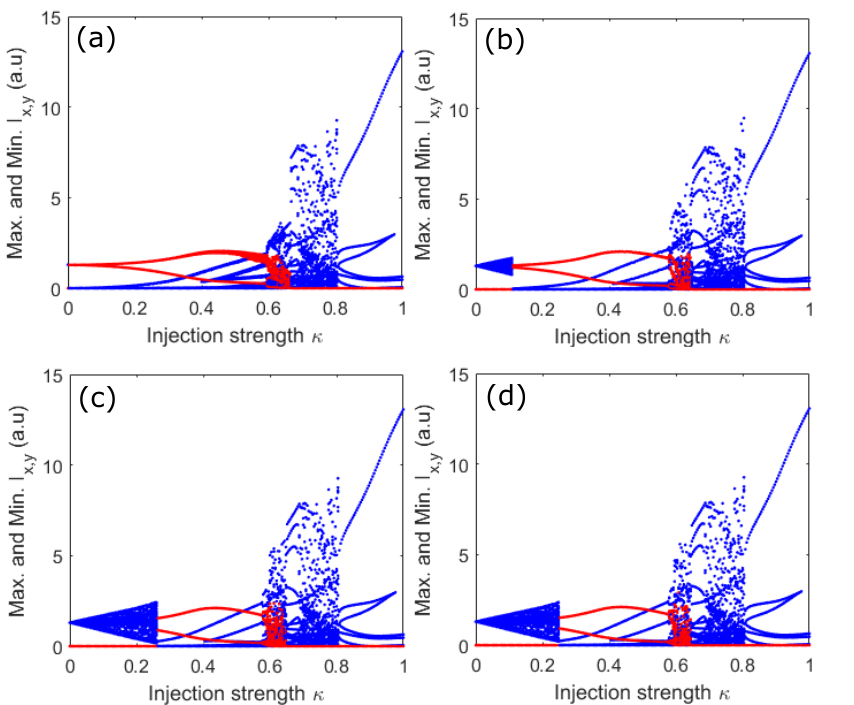
Figure 12. Bifurcation diagrams for fixed injected comb spacing Ω = 2 GHz and detuning ∆ ν x = − 9 GHz when varying γ s . ( a – d ) are obtained for γ s = 50 ns and γ s = 2300 ns − 1 ,